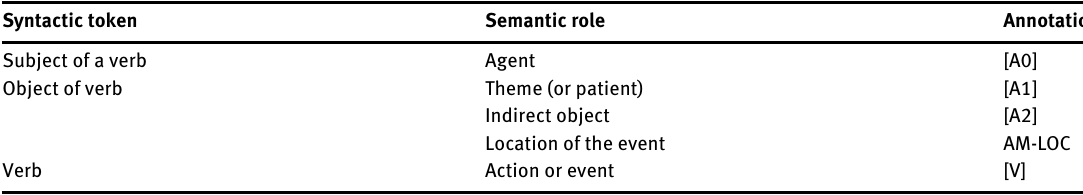
Table 1: Syntax, Semantic, and Symbolic